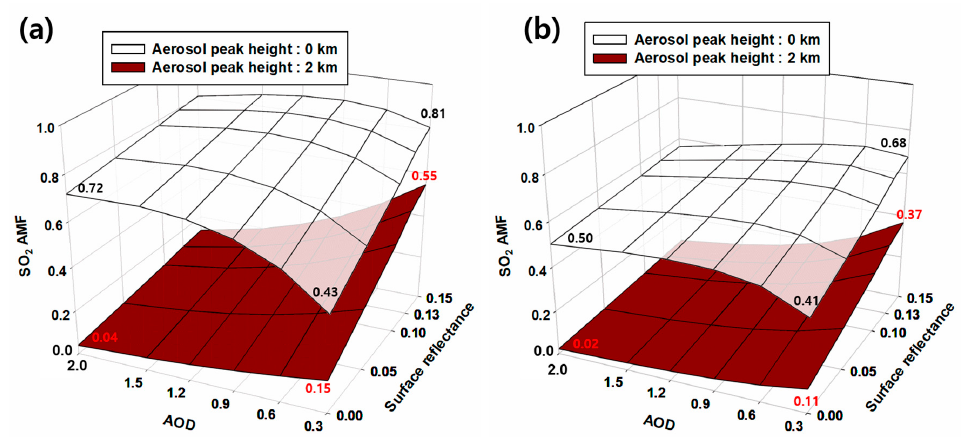
Figure 8. Changes in PBL SO 2 AMF as a function of AOD and surface reflectance at APH = 0 and 2 km under the conditions of ( a ) SZA = 20 ◦ and ( b ) SZA = 60 ◦ (VZA = 40 ◦ ; RAA = 45 ◦ ; surface reflectance = 0.05; O 3 VCD = 275 DU; wavelength = 318 nm).